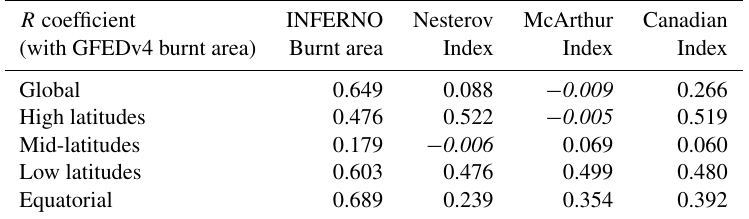
Table 4. Temporal correlation coefficients ( R ) of annual means (1997–2010) shown for four latitudinal bands. R coefficients were obtained between either of the three simulated fire indices or INFERNO’s burnt area (ubiquitous ignitions – ignition mode 1, using CRU-NCEP meteorology) and burnt area from GFEDv4 (Giglio et al., 2013). Italics mean the correlation was not significant ( p value above 0.05). We restrict our analysis to grid-boxes in which GFEDv4 observed burning. Latitudes were bound to: beyond 50 ◦ (high latitudes), 35 to 50 ◦ (mid-latitudes), 15 to 35 ◦ (low latitudes) and below 15 ◦